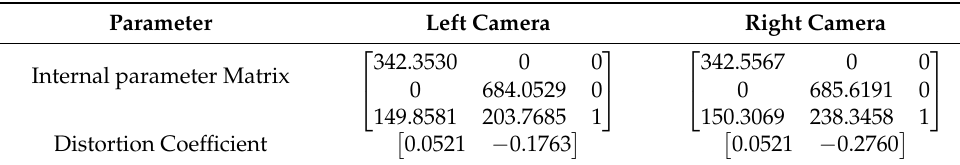
Table 2. Camera internal parameter table.